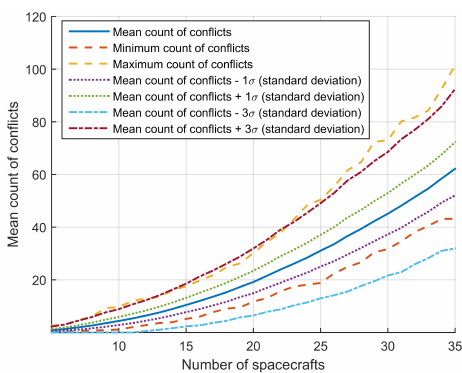
Figure 4. The example of range of variation of the conflicts’ number for 5 control facilities